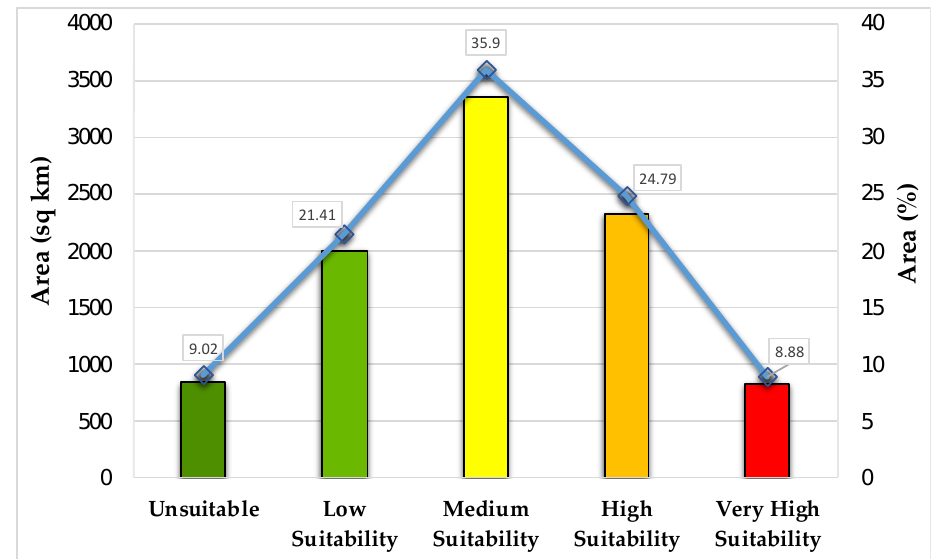
Figure 14. RWH final suitability map of the study area.